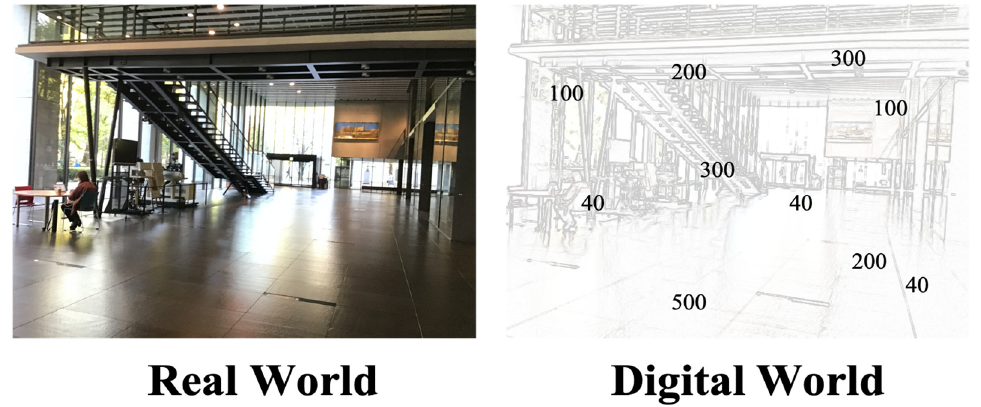
Figure 1. Digital